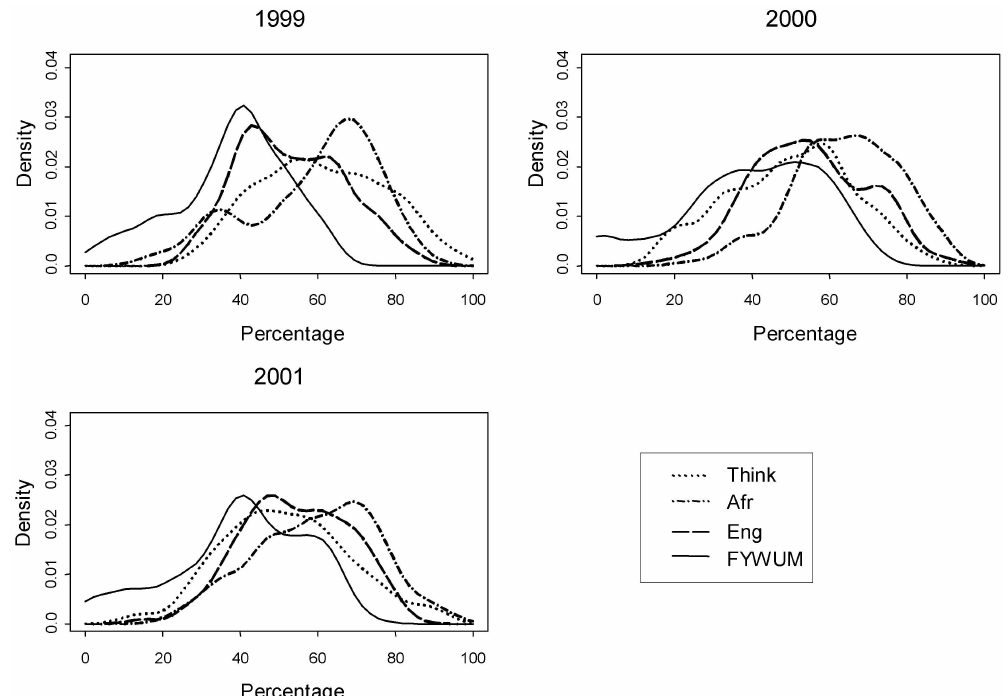
Figure 7: Kernel densities of the access test variables and the FYWUM of the Test Battery 3 data sets for 1999, 2000 and